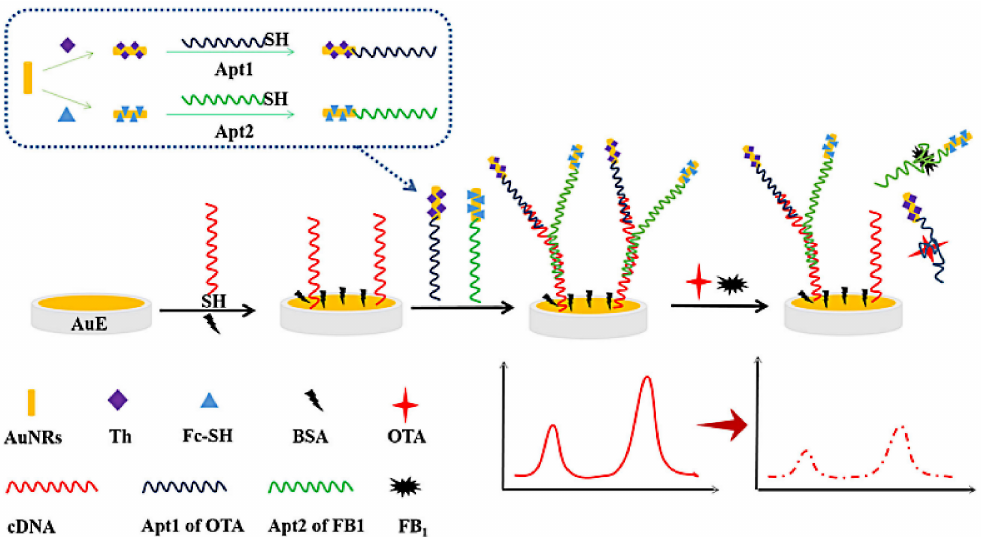
Figure 4. Schematic representation of OTA and FB1 detection based on Apt2-AuNRs-Fc/Apt1- AuNRs-Th/cDNA/AuE. Reproduced with permission from Wei et al. [93], Microchim. Acta; pub- lished by 2020 Springer Nature Switzerland